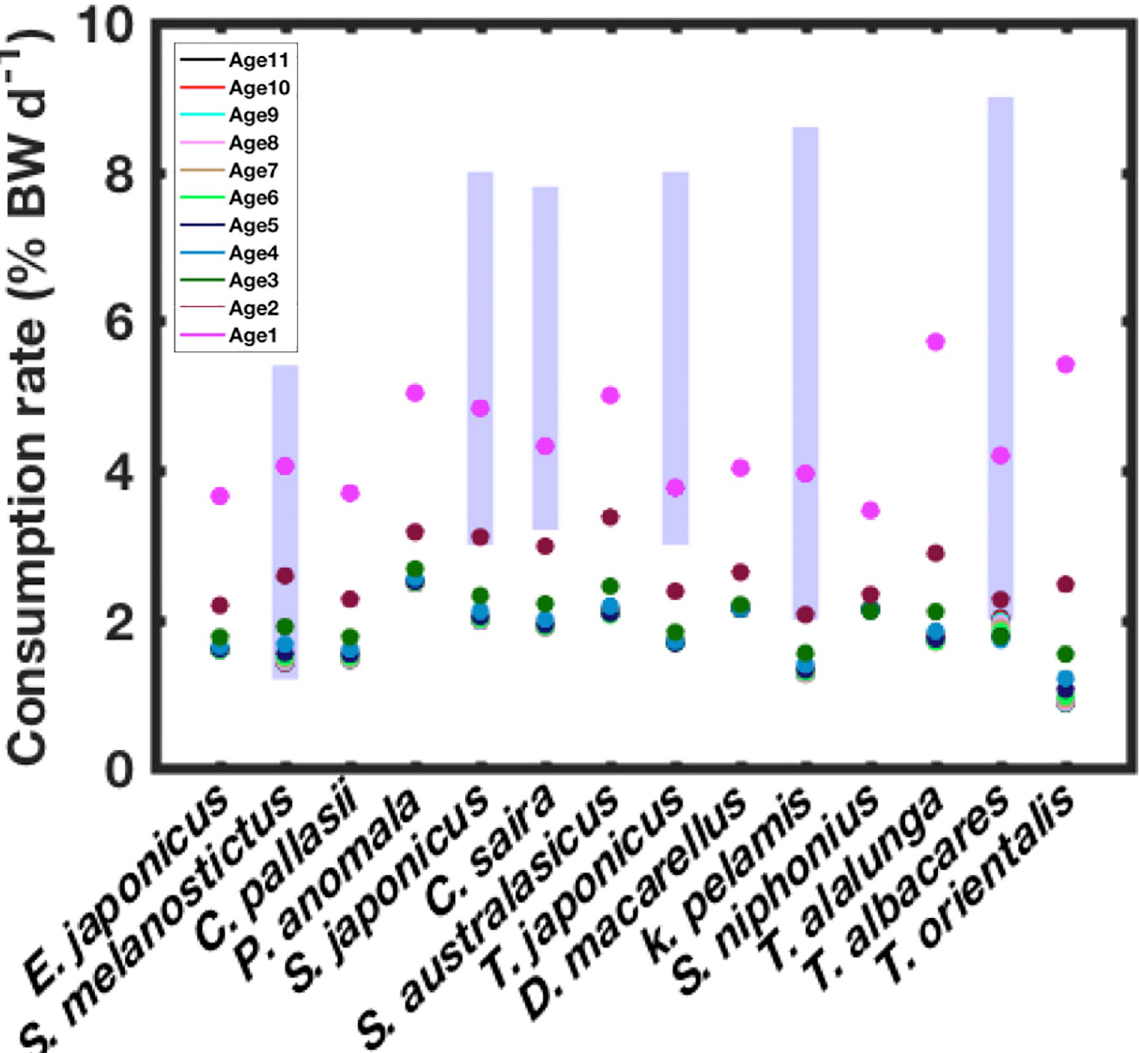
Fig 4. Estimated consumption rates for the 14 studied species, confronted with the variability ranges of the consumption rates reported in the literature (blue bars). The colours of the dots correspond to the different cohorts (2002–2013). The observed data are collected from the references [39–50].The studied species are shown in an increasing order of their asymptotic maximum